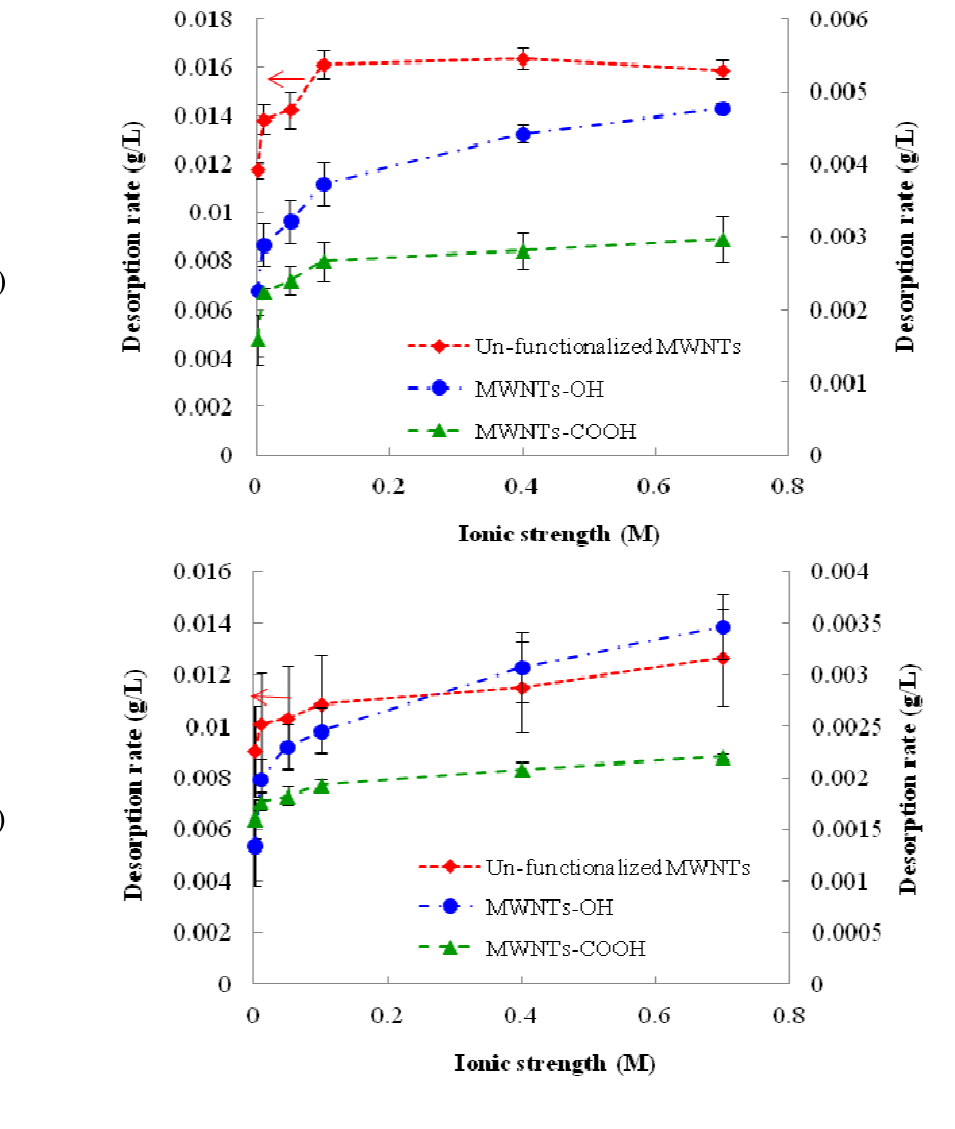
Figure 1. Change of the desorption rate of pre-loaded 1,3,5-TCB from multi-walled carbon nanotube (MWNTs) with different solution ionic strength and composition. ( A ) solutions containing CaCl ; ( B ) solutions containing NaCl. The reported values are the average of 2 three or four replicates. Error bars stand for standard